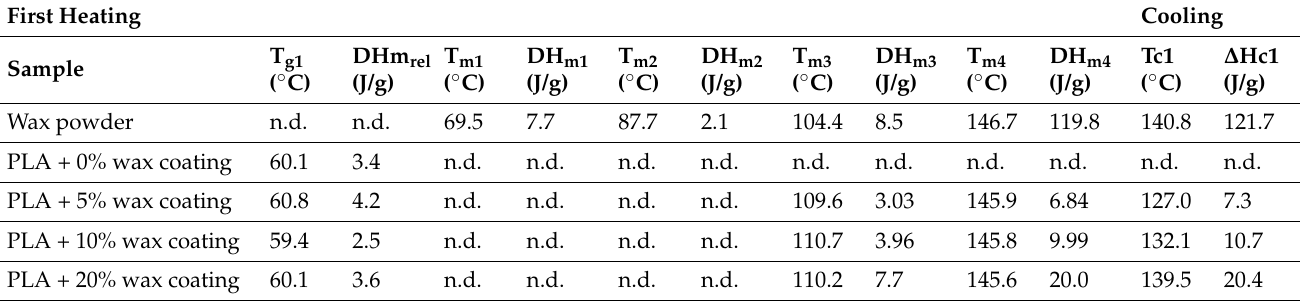
Figure 5. DSC first heating ( a ) and cooling ( b ) thermograms of wax powder and PLA coating layers with 0%, 5%,10% and 20% of wax. Table 3. Thermal parameters of the wax powder and PLA coating layers with 0%, 5%,10% and 20% of wax, related to the first heating and cooling